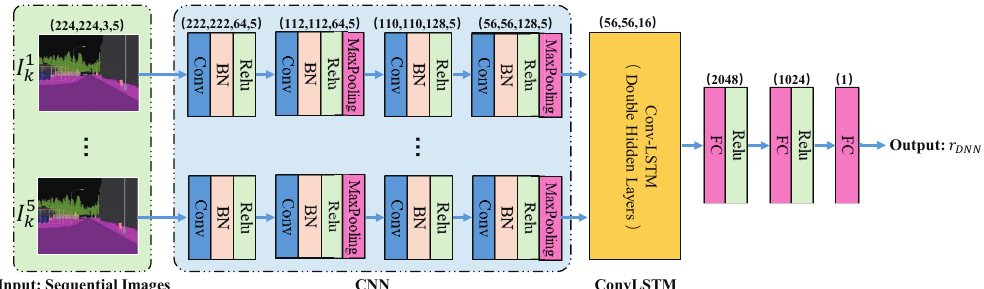
Figure 3. The DNN structure of the reward model. The inputs of the reward model are sequential images whose size is (224,224,3,5), and they are fed into the CNN to generate a feature map with the size of (56,56,128,5), then the feature map is fed into Conv-LSTM to extract the timing features among the sequential images which will be input to the fully connected layer to generate the output r DNN . CNN uses the first six layers of the VGG16 (BN) network and loads the corresponding pre-training